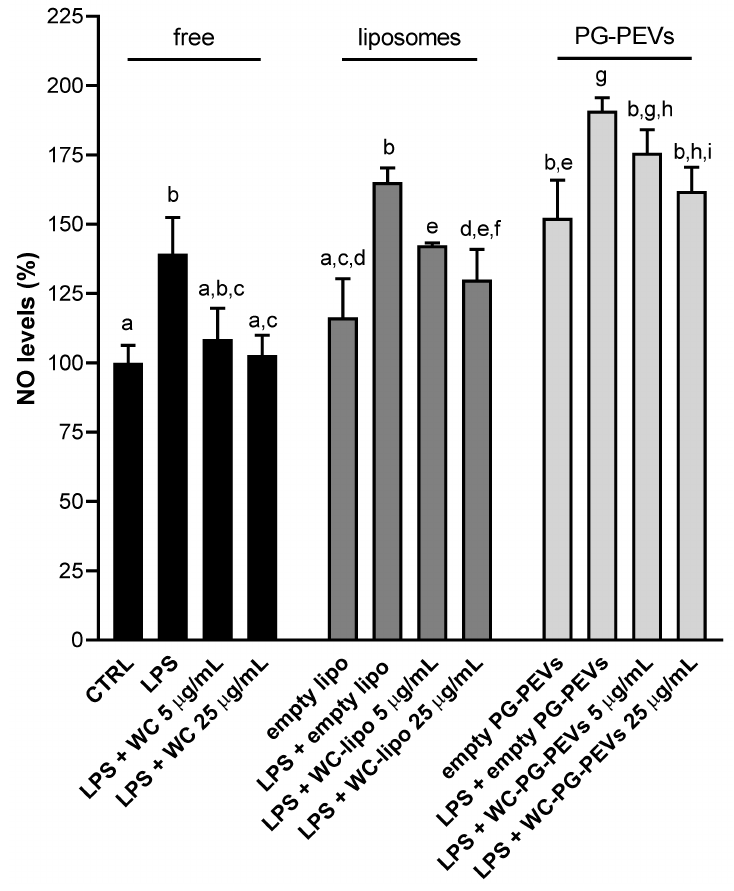
Figure 4. Effect of free WC, WC liposomes, and WC PG-PEVs on NO production. LPS-triggered U937/PMA cells were treated with 5 and 25 µ g/mL of WC, WC liposomes, and WC PG-PEVs. After 24 h, NO levels were quantified. Means ± S.D. of four replicate independent experiments are shown. Since differences were statistically significant (one-way ANOVA, p < 0.05), Tukey’s test was performed and different letters above the bars indicate significant differences between treatments at p < 0.05. Abbreviations: CTRL, untreated cells; WC, free WC; empty lipo, empty liposomes; and WC-lipo, WC